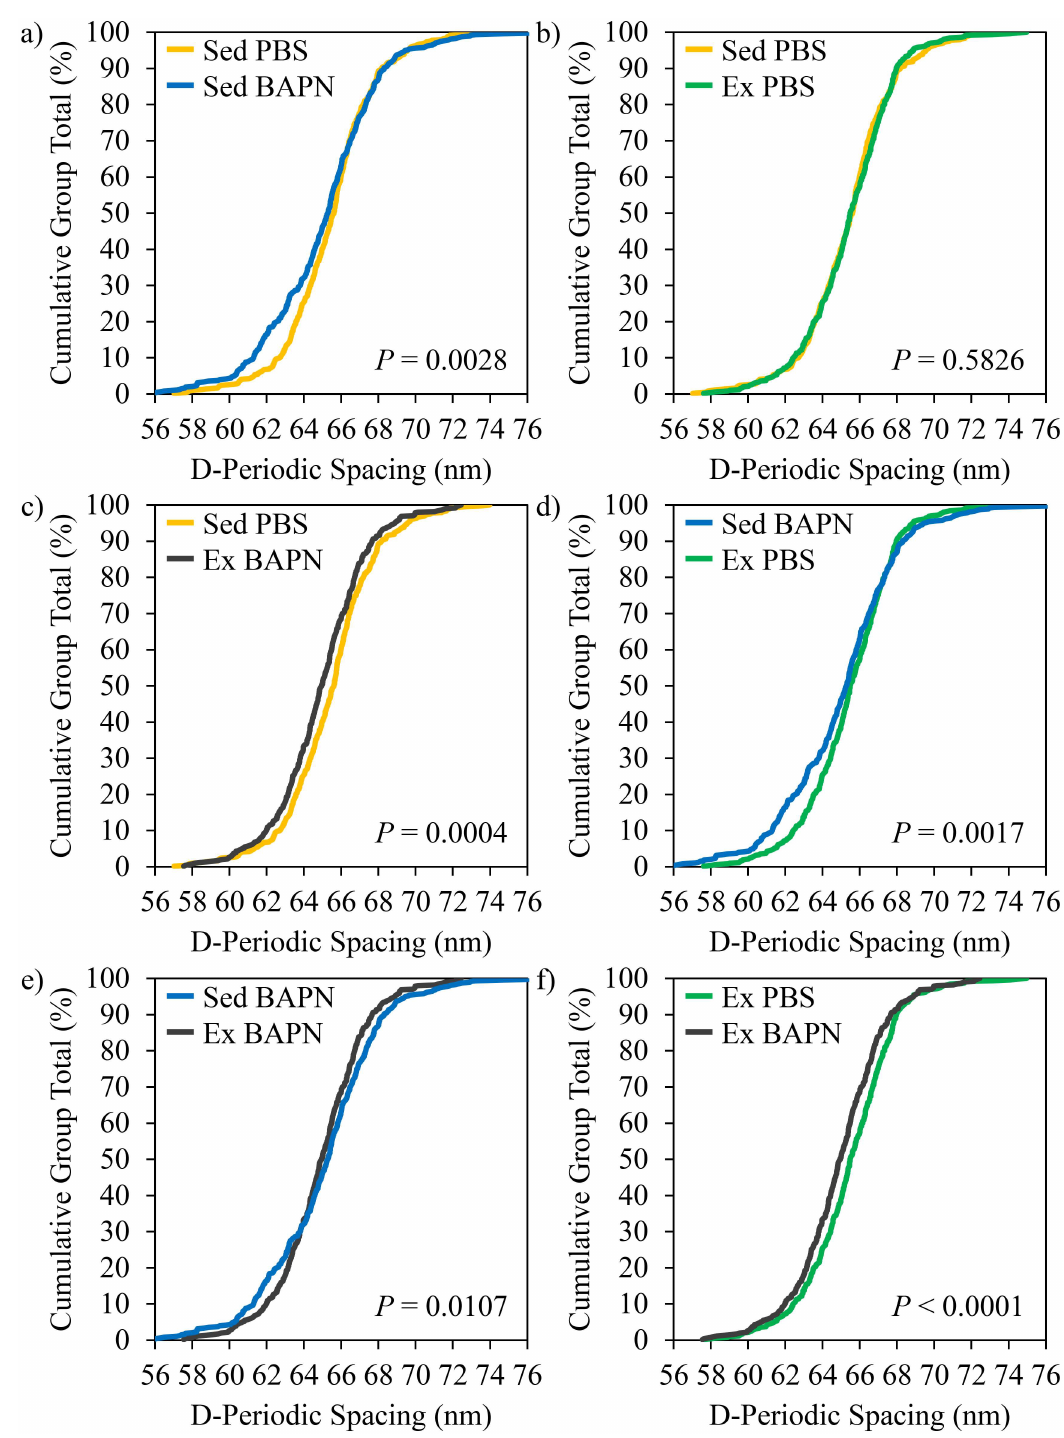
Fig 2. D-spacing distributions. Pairwise comparisons of D-spacing from AFM. a) Sed BAPN vs. Sed PBS. b) Ex PBS vs. Sed PBS. c) Ex BAPN vs. Sed PBS. d) Ex PBS vs. Sed BAPN. e) Ex BAPN vs. Sed BAPN. f) Ex BAPN vs. Ex PBS.